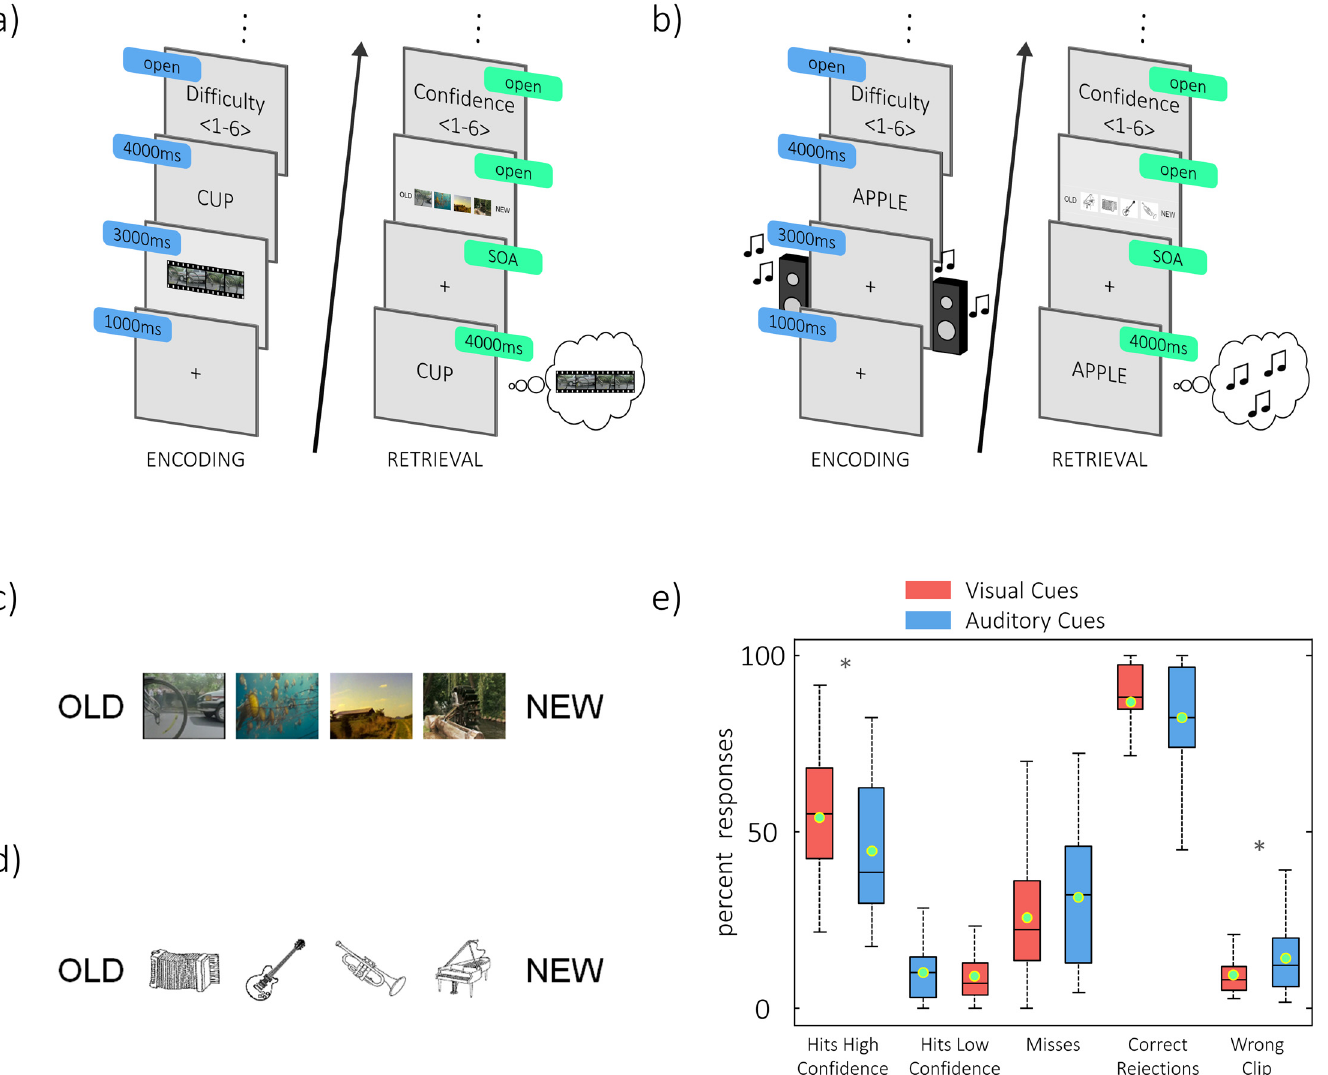
Fig 1. Experimental design and behavioral results. (a,b) Trial sequences are shown for the visual (a) and the auditory session (b). In the encoding block (a,b left), participants were presented with a dynamic stimulus that played for 3 s and was immediately followed by a word cue, which was presented for 4 s. During encoding, subjects learned 120 associations between four repeatedly shown dynamic stimuli and 120 different words. At the end of every encoding trial, the perceived difficulty of the association was rated on a scale from 1 to 6. In the retrieval block (a,b right), subjects only saw the static word cue and were asked to vividly recall the dynamic stimulus it was associated with. Cues from encoding were mixed with 60 new words that served as distractors. Note that during encoding, the word cue was shown after the dynamic stimulus, avoiding sensory overlap between encoding and retrieval. Subjects were then asked to indicate the stimulus they recalled. Response options (c,d) consisted of four small screenshots of the video clips in the visual condition (c) and of four small instruments, representing the sounds, in the auditory condition (d). Additionally, the response option “ NEW ” was presented to indicate that the word was not presented in the encoding block (distractor item), the response option “ OLD ” was available to indicate that subjects remembered learning the word, but could not recall the content it was associated with. After responding, subjects were asked to rate the confidence in their answer on a scale from 1 to 6 (a,b right). (e) Behavioral performance is plotted. Hits are trials in which the correct associate was remembered (i.e., video or sound). A rating of high confidence was considered a rating > 4. Misses were defined as those trials in which the associate was not remembered and as those trials in which a word cue was wrongly named as a distractor. Boxes are 25th and 75th percentiles around the median, whiskers represent minimum and maximum, green points are arithmetic means. * p <